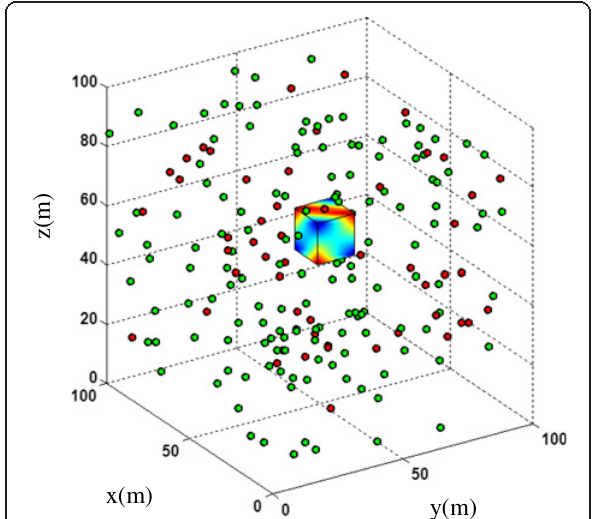
Fig. 1 Initial location distribution of nodes